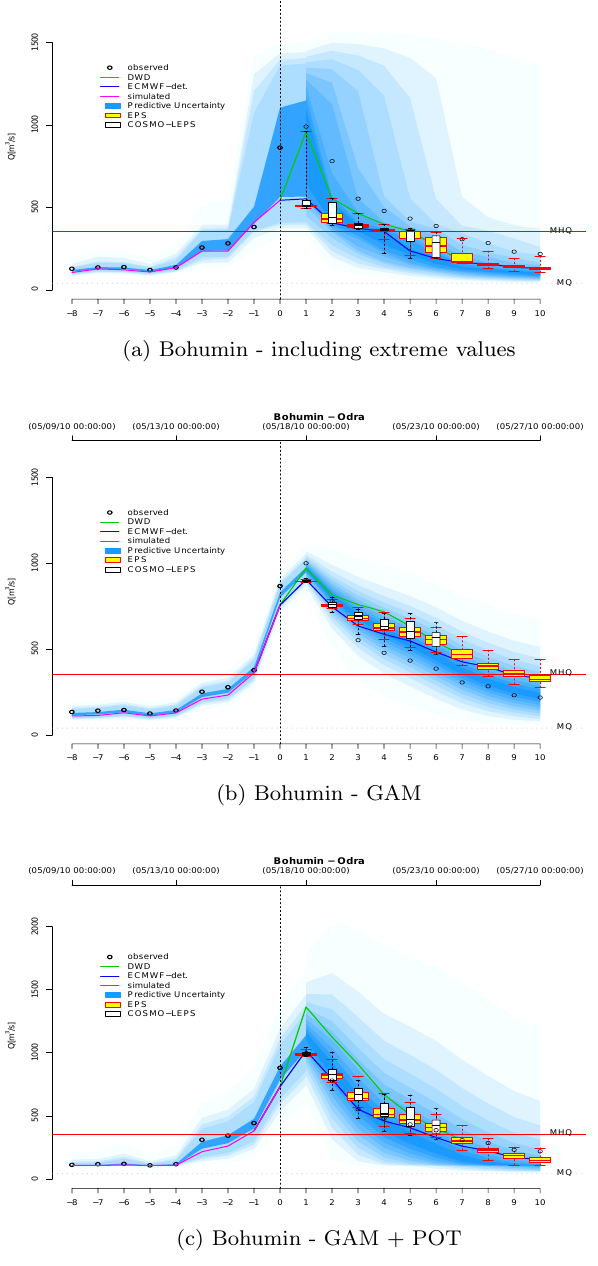
Fig. 5. Resulting forecast at station Bohumin applying three differ- ent extrapolation methods: including extreme values based on the POT method (a) , fitting the GAM to the historical measurements and linear extrapolation (b) , combining the POT and the GAM (c)